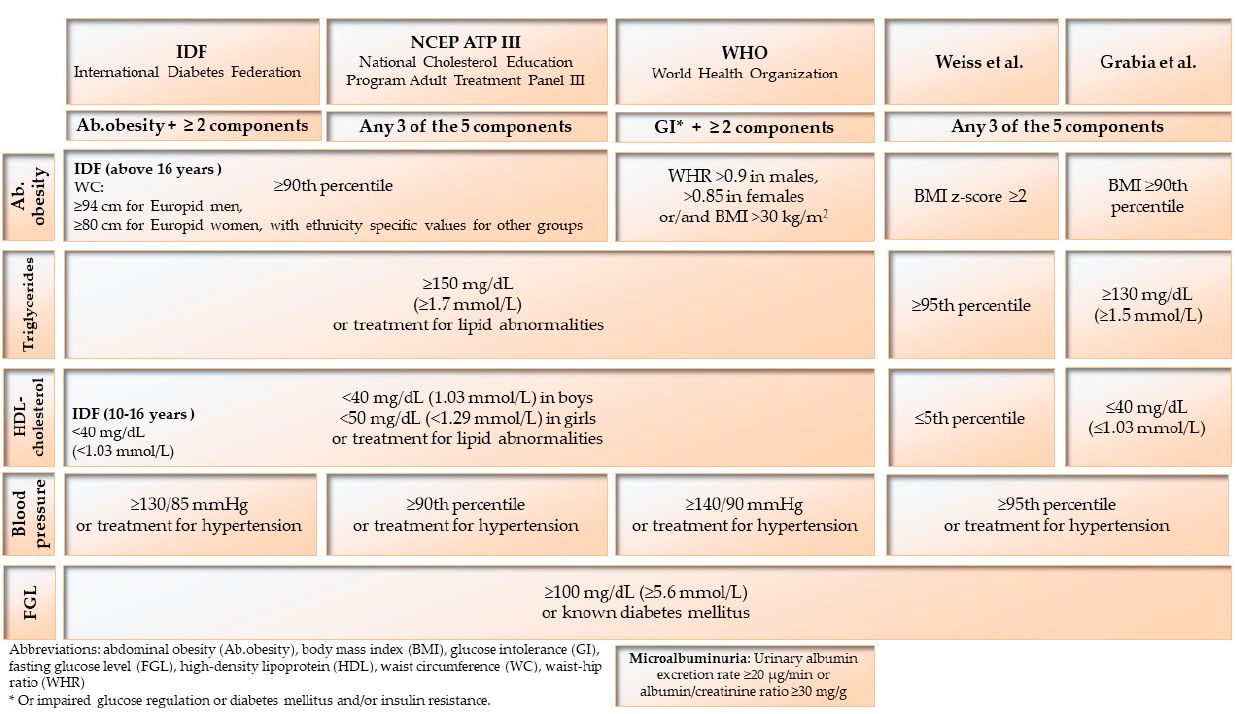
Figure 2. Criteria of metabolic syndrome (MetS) diagnosis in children and adolescents [7–9,14].